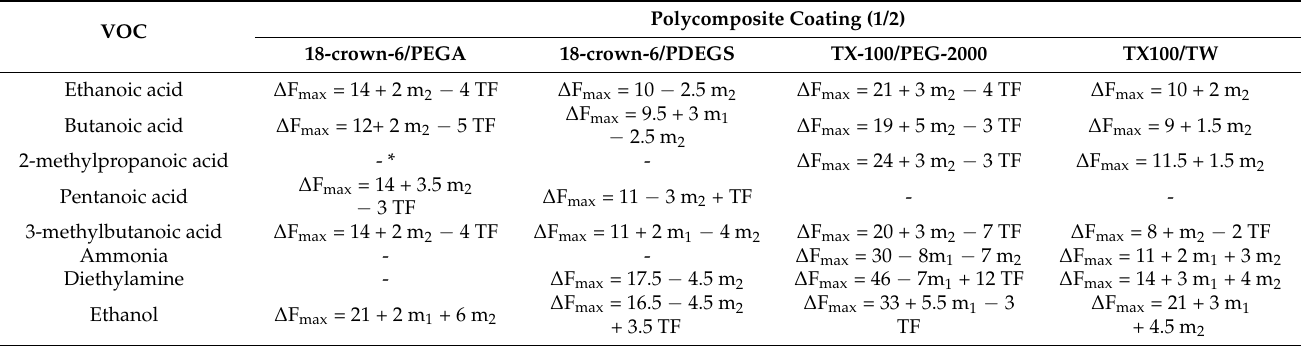
Table 6. Regression equations for predicting the analytical signals of sensors ( ∆ F max , Hz) based on polycomposite coatings depending on the mass of sorbents (m 1 , m 2 ) and technique of formation (TF) ( p = 0.95, n =